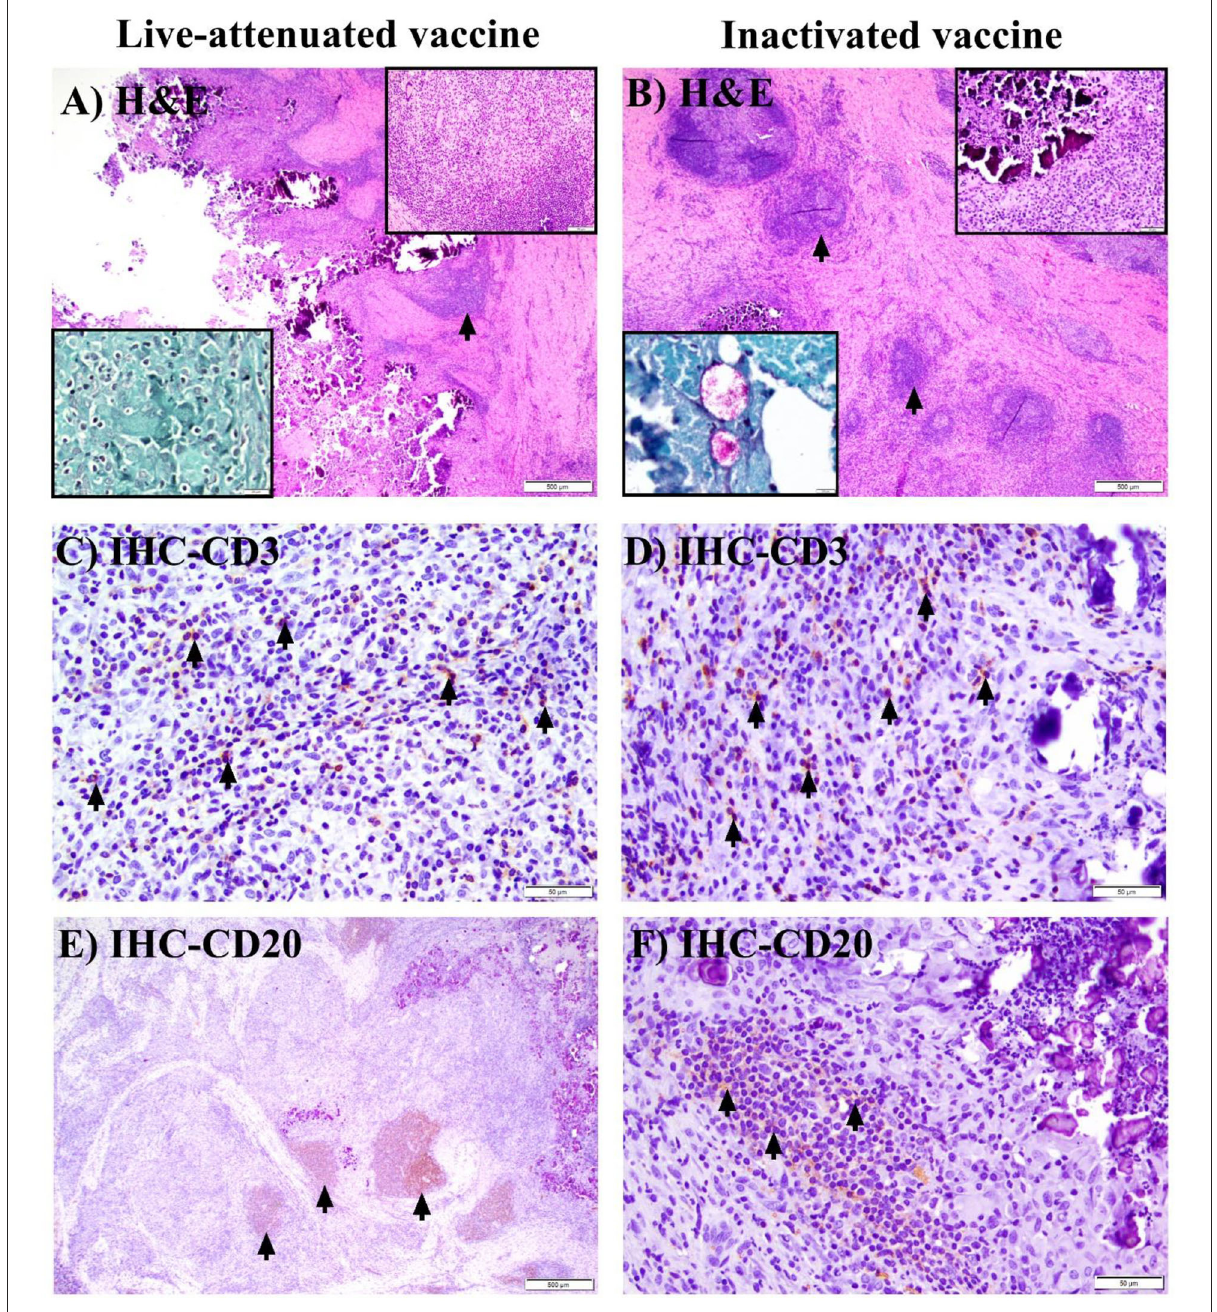
FIGURE5 Histopathology of granuloma formation in goats after immunization with live attenuated or inactivated vaccine at 6 months post vaccination. (A, B) Hematoxylin and eosin (H&E) stained sections from subcutaneous granulomas at the site of injection of a single SC-vaccinated goat (no other goats in the live-attenuated cohort had grossly or histologically evident granulomas, while all goats in the inactivated vaccine group had subcutaneous granulomas). Arrows point to lymphoid nodular aggregates at the periphery of granulomas, with peri-granuloma lymphocyte recruitment further highlighted by the top (H&E) inset (A) (bar = 100 µ m) and top (H&E) inset (B) (bar = 50 µ m). The bottom (acid-fast stain) inset in (A) shows lack of AFB in subcutaneous granulomatous areas (A) in the single pgsN-vaccinated animal; in contrast, extracellular bacilli are present within the caseating center of subcutaneous granulomas in the inactivated vaccine group [ (B) ; acid-fast stain, bottom inset]. (C, D) Immunohistochemistry (IHC) staining of the sections in (A, B) with arrows highlighting CD3 + T lymphocytes located at the periphery of granulomas (bars = 50 µ m). (E, F) IHC staining of the sections in (A, B) with arrows pointing to CD20 + B lymphocytes forming large nodular aggregates that peripheralize granulomas (bars = 500 and 50 µ m,